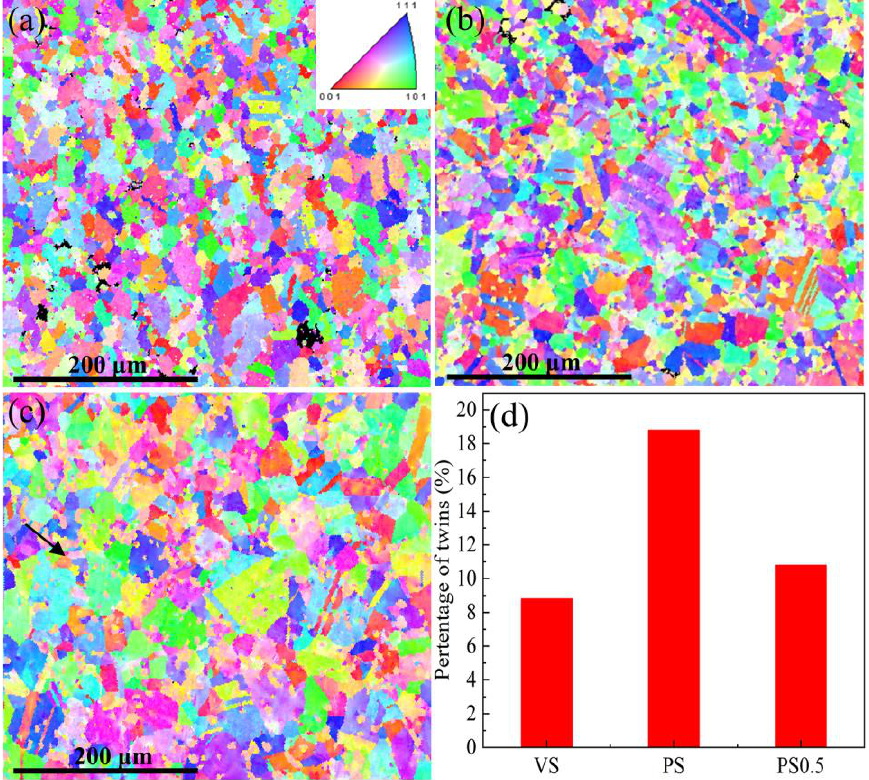
Figure 6. The EBSD IPF diagram of alloys at 10% tensile strain: ( a ) VS, ( b ) PS, ( c ) PS0.5; ( d ) the percentage of twins.